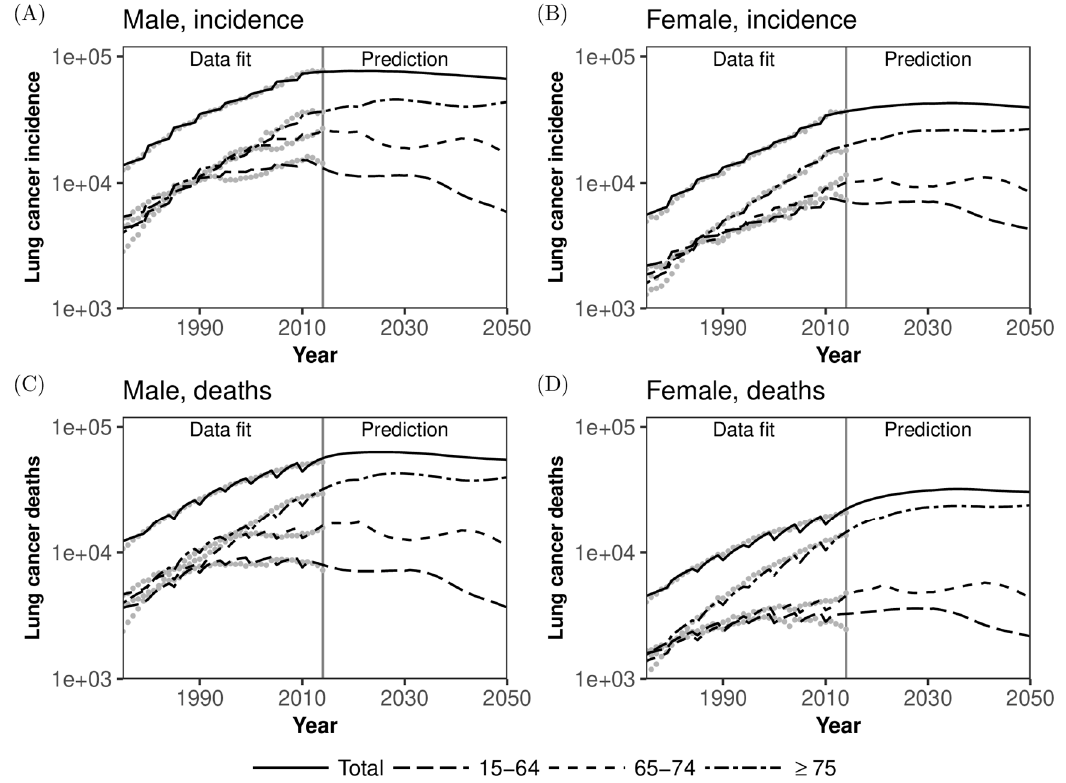
Figure A2. Comparisons between observed and predicted absolute numbers of lung cancer cases and deaths in Japan. Note that the vertical axis is in logarithmic scale. Comparisons between observed and predicted absolute numbers of lung cancer cases and deaths are shown by age group and sex. ( A ) Lung cancer incidence in men, ( B ) Lung cancer incidence in women, ( C ) Mortality in men, and ( D ) Mortality in women. Bold dashed line represents working-age population aged 15–64 years, thin dashed line corresponds to those aged 65–74 years, uneven dashed line represents those aged 75 years or older, and solid line represents the entire population. Grey dots before 2014 were used to estimate model fitting parameters via the maximum likelihood method, and lines for 2015 and later indicate predictions calculated using maximum likelihood estimates at the latest time. The 95% confidence intervals are omitted from predictions because of the narrow uncertainty bounds.